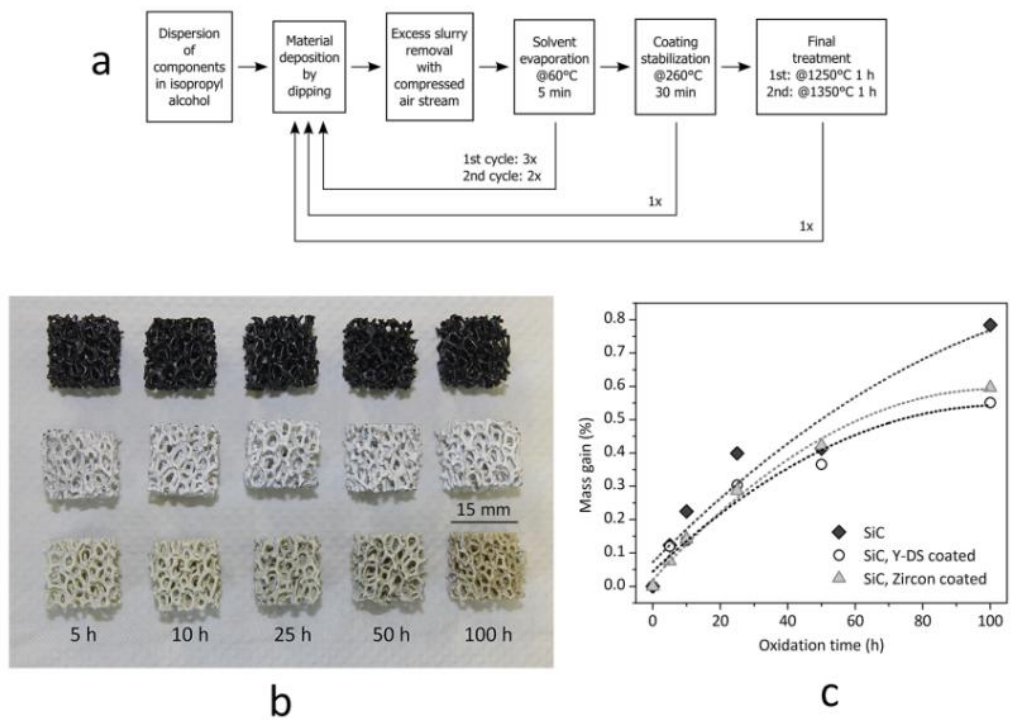
Figure 5. Silicate coatings on Si-SiC foams: ( a ) diagram of the procedure of coating/heat treatment; ( b ) visual appearance of samples (top line: un-coated Si-SiC foams; middle line: polymer-derived coating with Y-silicate; bottom line: polymer-derived zircon coating) (edge length: 15 mm); ( c ) weight gains with increasing oxidation time at 1200